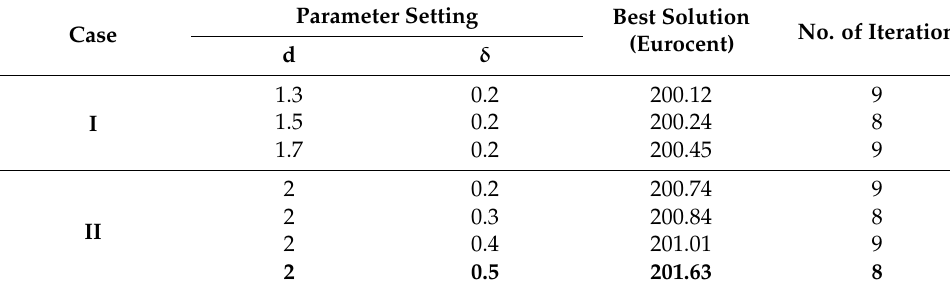
Table 4. Optimal parameter setting of the BAS